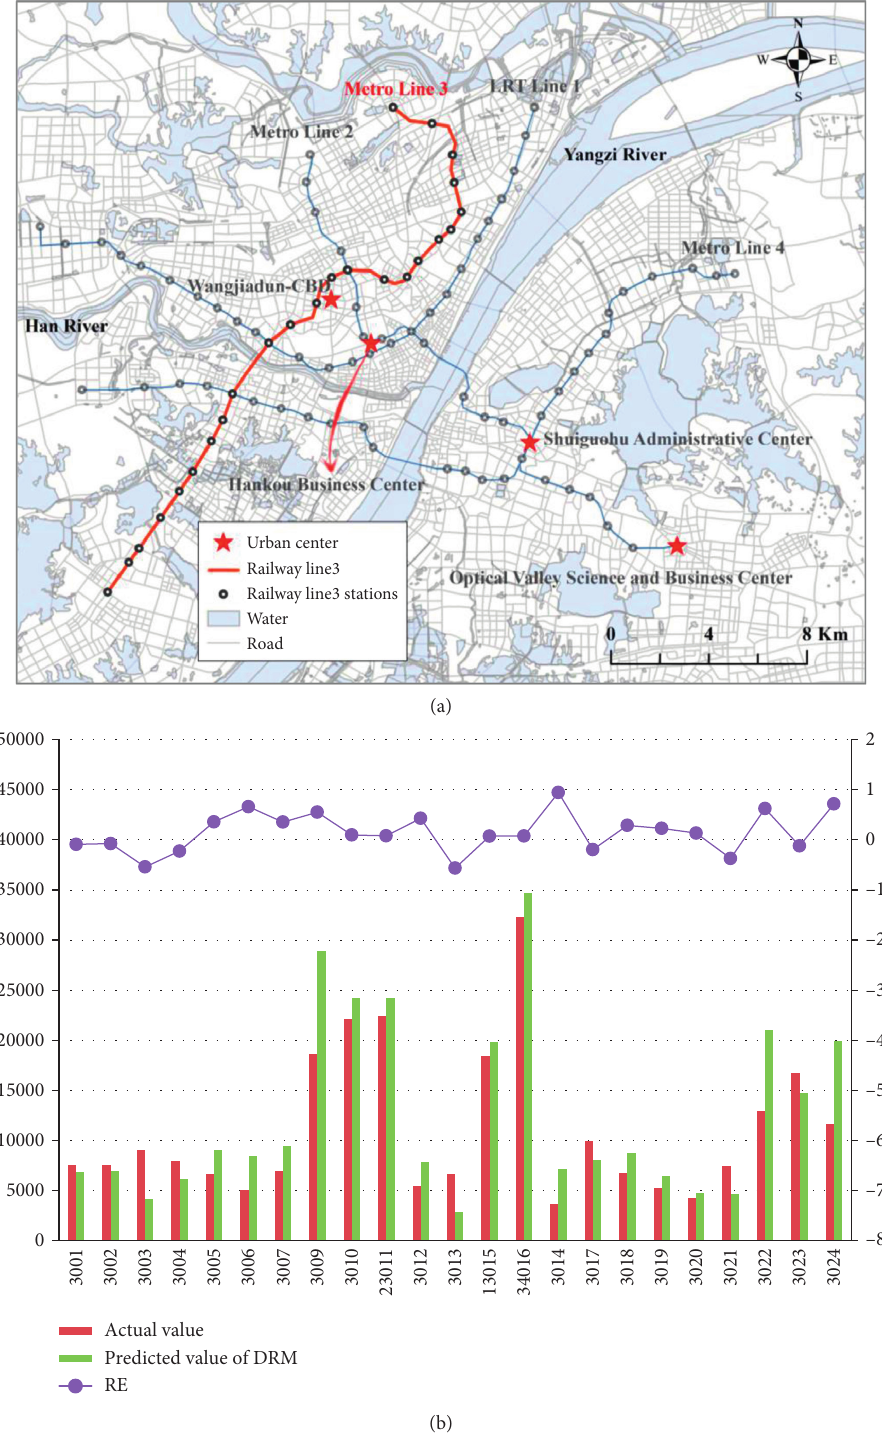
Figure 7: MRT Line 3 in Wuhan (a) and RE analysis (b)